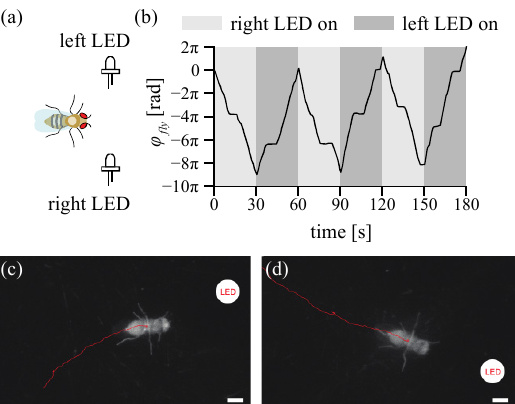
Figure 9. Phototaxis experiment setup and results ( a ) Schematics of the experimental setup. Broad- band light LEDs are located on both the left and right sides. Lights on each side are toggled every 30 s. ( b ) The heading angle ϕ fly of the walking fly during the experiment. The fly showed a positive phototaxis. When the right LEDs are on, the fly moves toward the right (Clockwise rotation, the heading angle decreases). When the left LEDs are on, it moves toward the left (Counter-clockwise rotation, the heading angle increases). ( c , d ) The example NIR imaged during the experiment. The red color line is the path of the fly for the last one second. The white circle (added artificially) is the location of the LED. The scale bar is 1 mm. ( c ) NIR image at 49.4 s when the left LED is on. ( d ) NIR image at 74.7 s when the left LED is on. See Video 3.